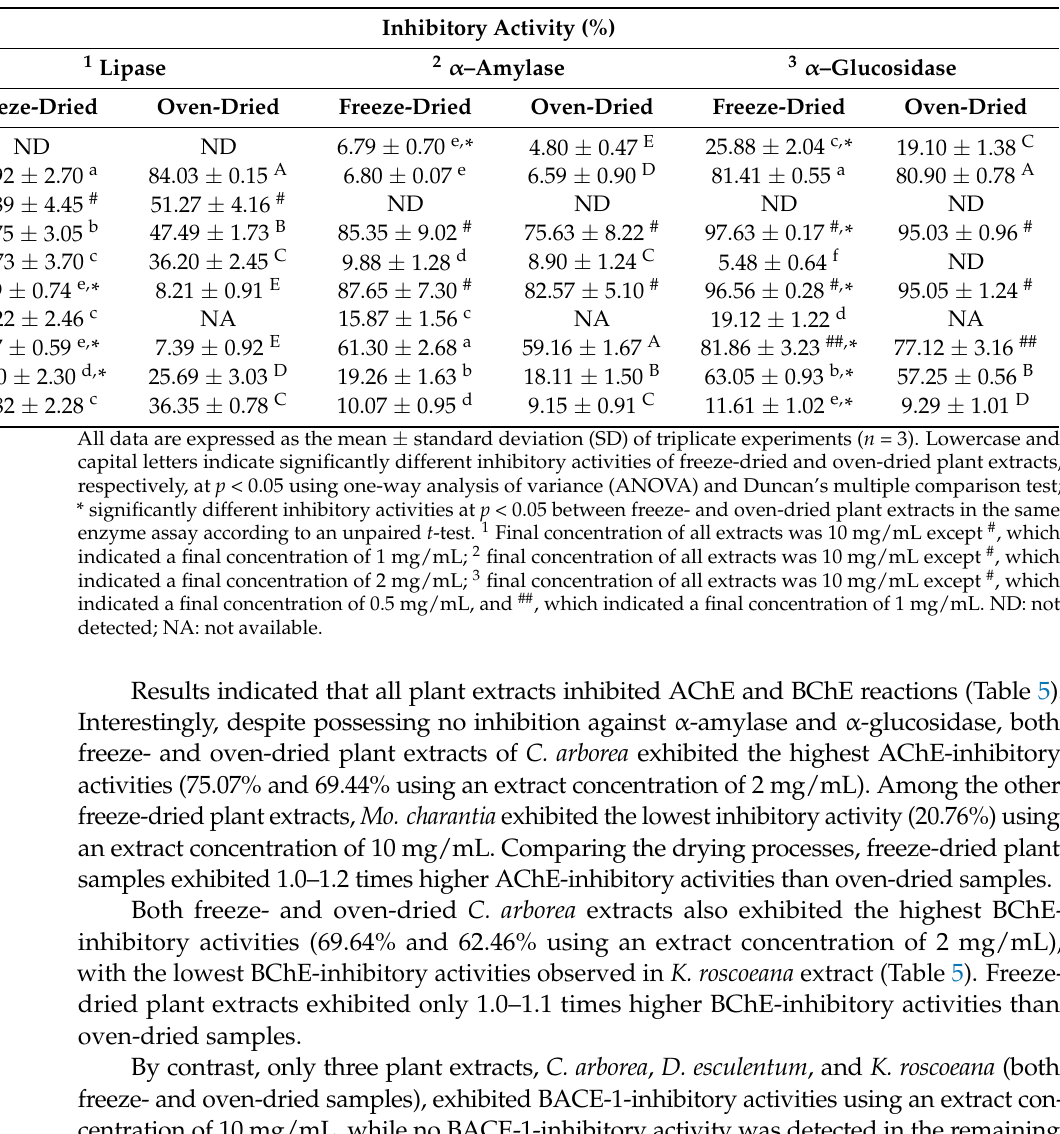
Table 4. In vitro inhibitory activities of 10 indigenous plant extracts prepared from freeze- and oven-drying processes against the key enzymes relevant to obesity (lipase) and diabetes ( α -amylase and α